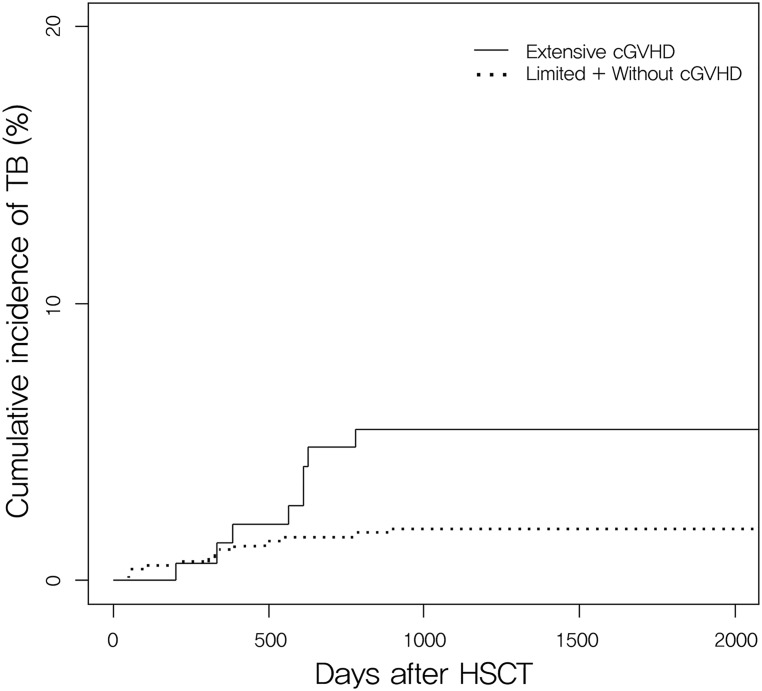
Cumulative incidence of tuberculosis in allogeneic hematopoietic stem cell transplantation recipients with and without chronic graft-versus-host-disease.Extensive chronic GVHD was associated with the development of TB (P = 0.003) There is a 4.89 ± 1.32% probability of having TB disease at 1000 days after allogeneic HSCT for extensive chronic GVHD and 1.42 ± 0.50% for limited or without chronic GVHD. cGVHD, chronic graft-versus-host disease; HSCT, hematopoietic stem cell transplantation; TB, tuberculosis.